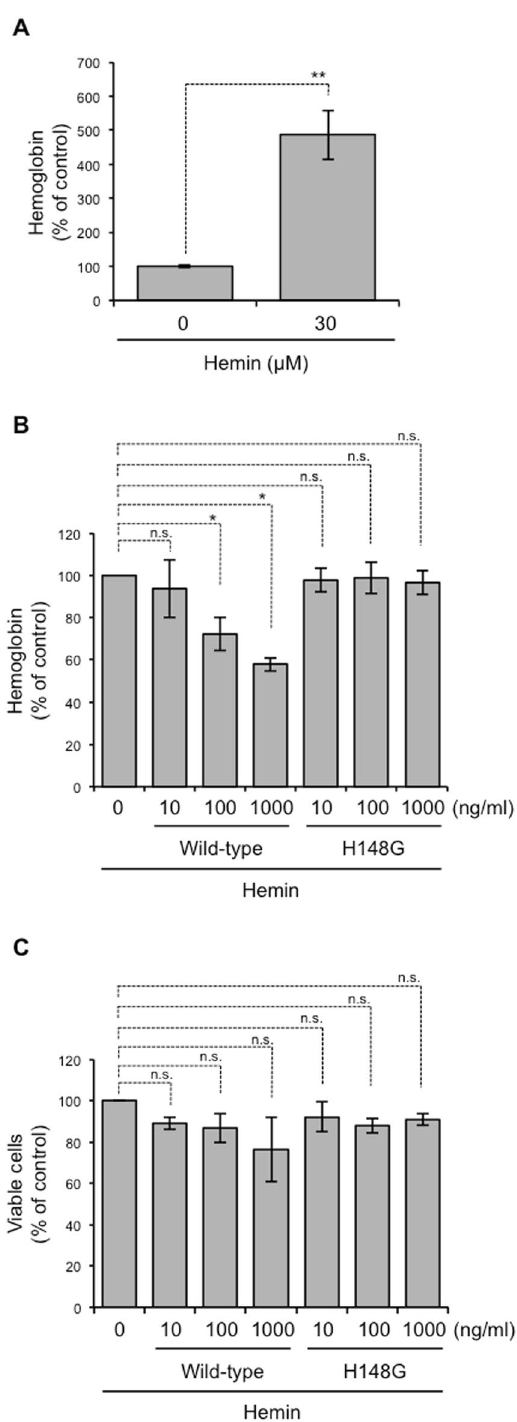
Figure 5. α -Toxin impairs differentiation of K562 cells. K562 cells were cultured in the presence of 30 μ M hemin. Simultaneously, the cells were treated with 10 ng/ml α -toxin (Wild-type) or a variant α -toxin (H148G). ( A , B ) Hemoglobin synthesis in K562 cells was determined using a TMB assay. The relative amounts of hemoglobin are expressed as a percentage relative to the control cells. ( C ) The cell viability was evaluated using a CCK-8 assay. The relative cell viabilities are expressed as a percentage relative to α -toxin-untreated control cells. One-way ANOVA and two-tailed Student’s t-test were employed to assess statistical significance. Values are mean ± standard deviation. * P < 0.05; ** P < 0.01; n.s., not